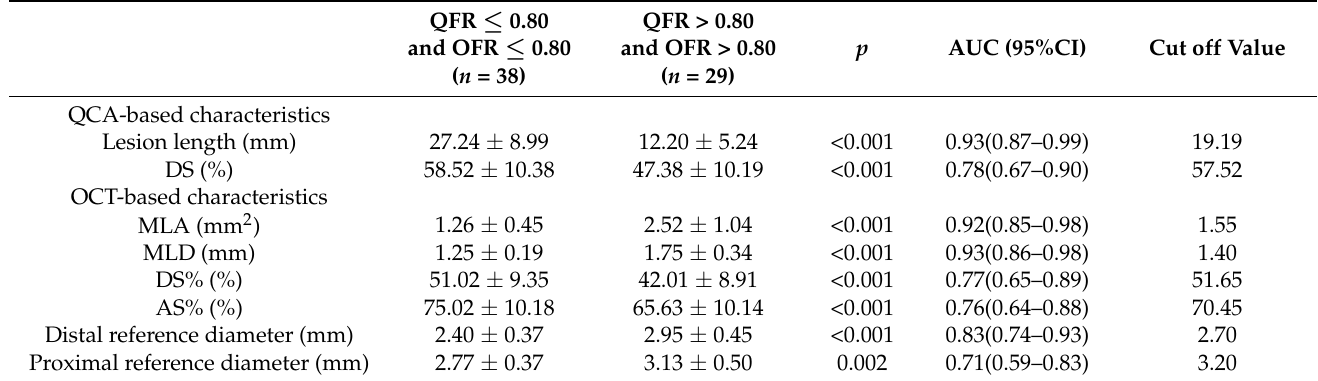
Table 5. Differences between parameters in QCA and OCT and the area of ROC and Cut-off value of parameters in QCA and OCT with OFR/QFR concordance.